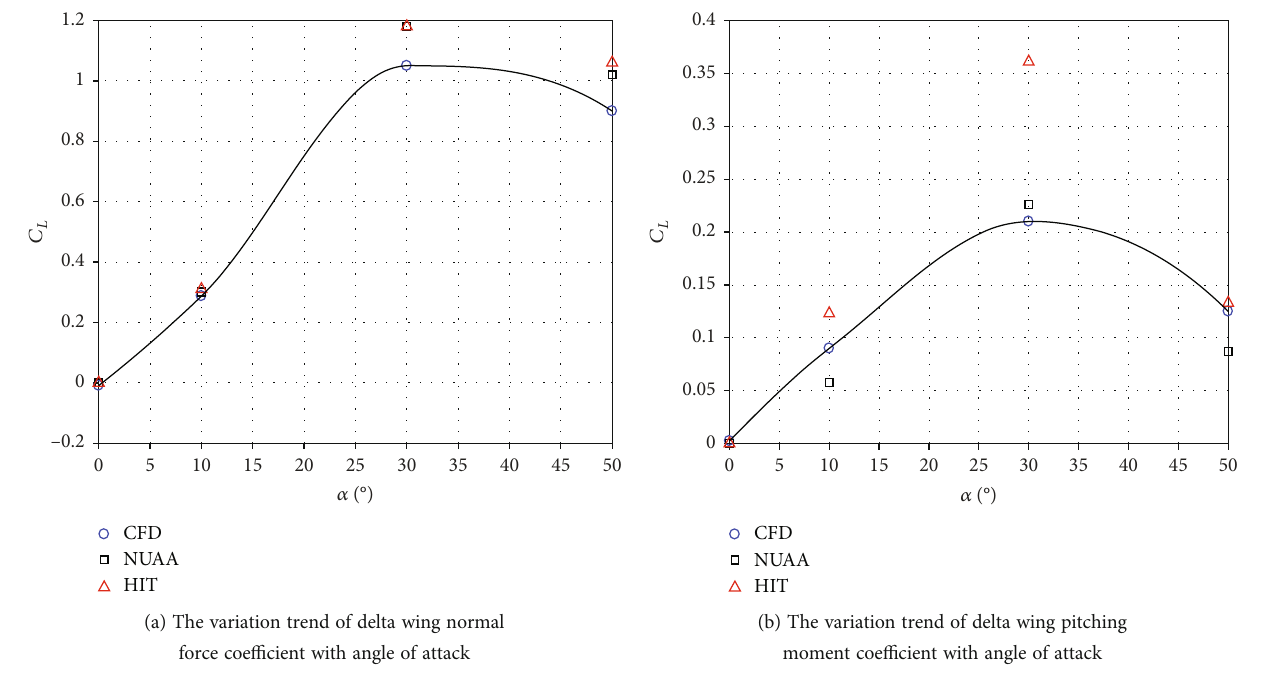
Figure 6: Comparison of experimental results and numerical results of delta wing